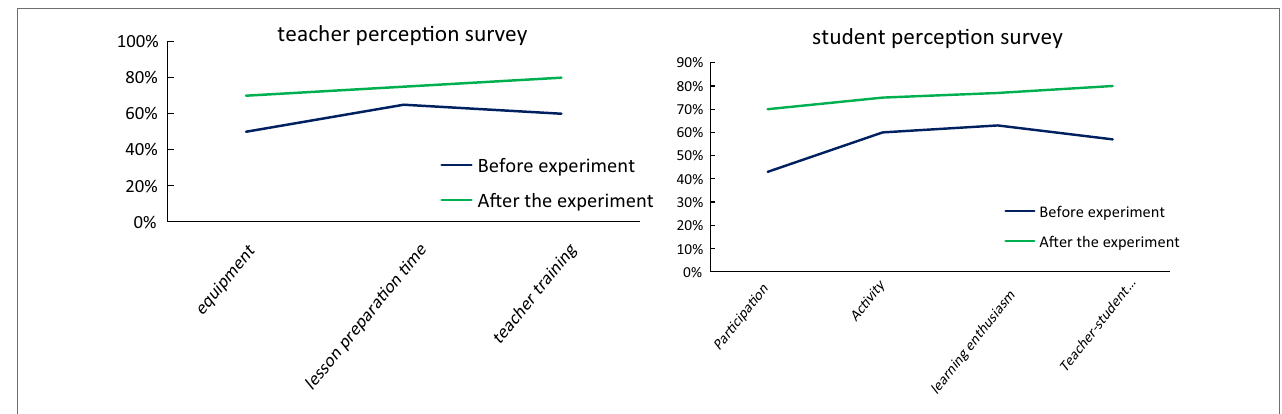
FIGURE 10 | A survey of teachers and students’ perceptions of interactive